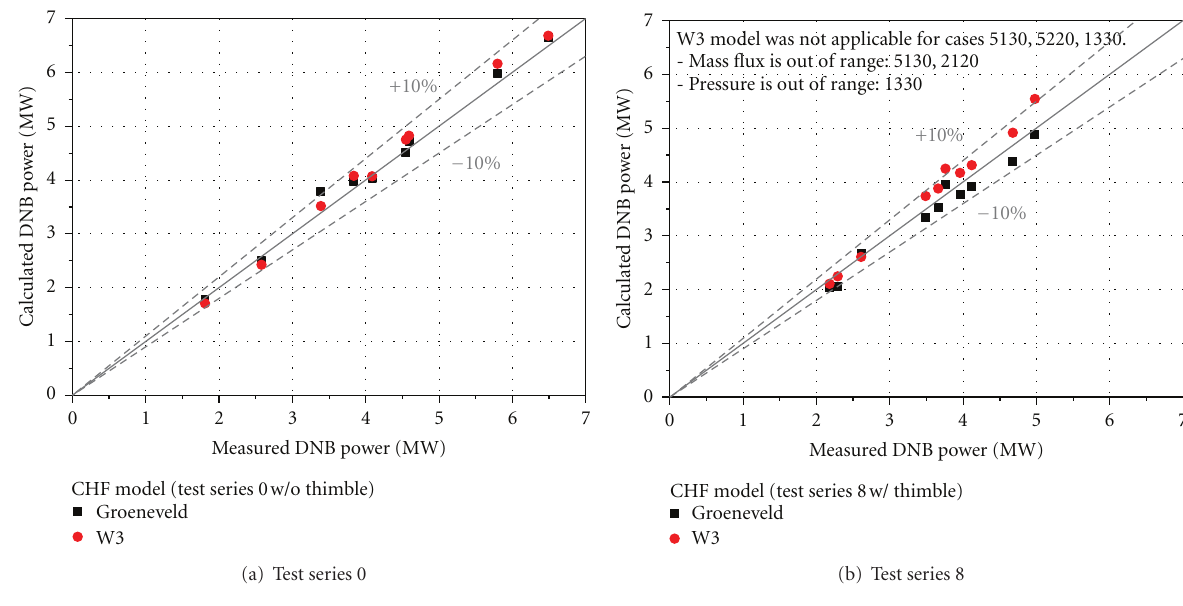
Figure 22: DNB Results with di ff erent CHF